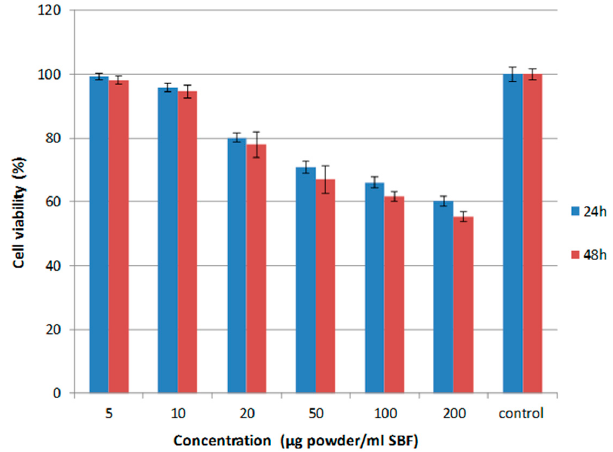
Figure 7. Cell viability of the SiCaMgOC-1100 powders with human embryonic kidney cells (HEK-293 cells).